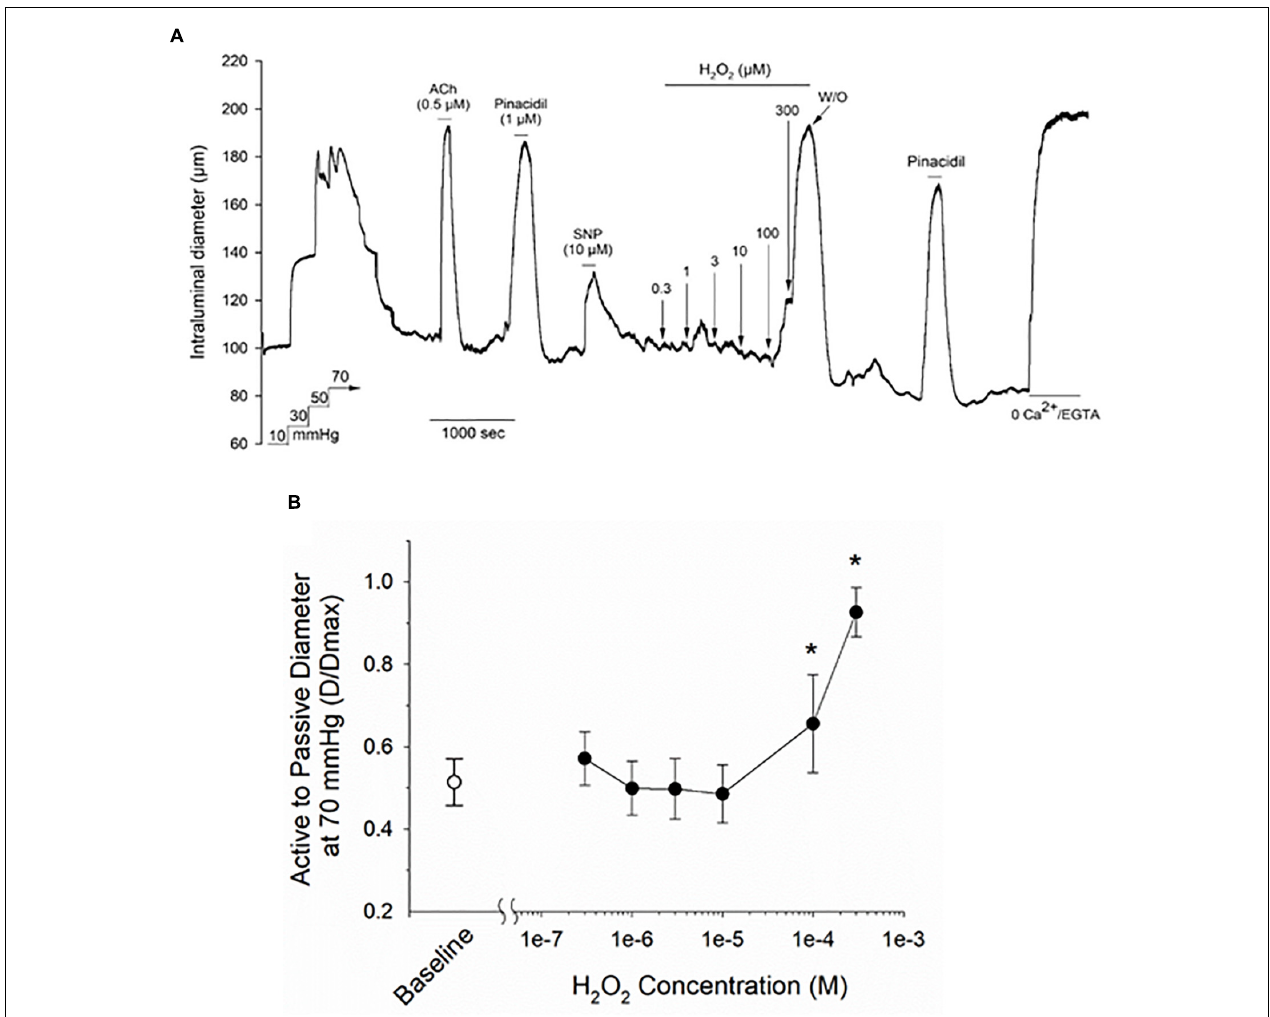
FIGURE 1 | Treatment with hydrogen peroxide (H 2 O 2 ) evokes a vasodilatory response in myogenically contracted rat cremaster arteries. Panel (A) shows a representative tracing from a cannulated cremaster artery from an adult Sprague–Dawley rat exposed to a range of H 2 O 2 concentrations, along with endothelium-dependent and -independent vasoactive agents. All agents were added to the bath perfusion solution and treatments are indicated by the horizontal lines above and below the tracing. Maximal arterial diameter was determined at the end of the protocol by bath perfusion with a nominally Ca 2 + free physiological saline solution (i.e., 0 added CaCl 2 + 2 mM EGTA). The ratios of intraluminal diameter in myogenically active arteries vs. diameter under passive conditions (i.e., 0 added CaCl 2 + 2 mM EGTA) at baseline and in the presence of the indicated concentrations of H 2 O 2 are plotted in panel (B) . The asterisk denotes a H 2 O 2 evoked change that is significantly different from the baseline level, as determined by one-way ANOVA and a Newman–Keuls post hoc test ( P < 0.05). Data are expressed as means ± SD, n = 5